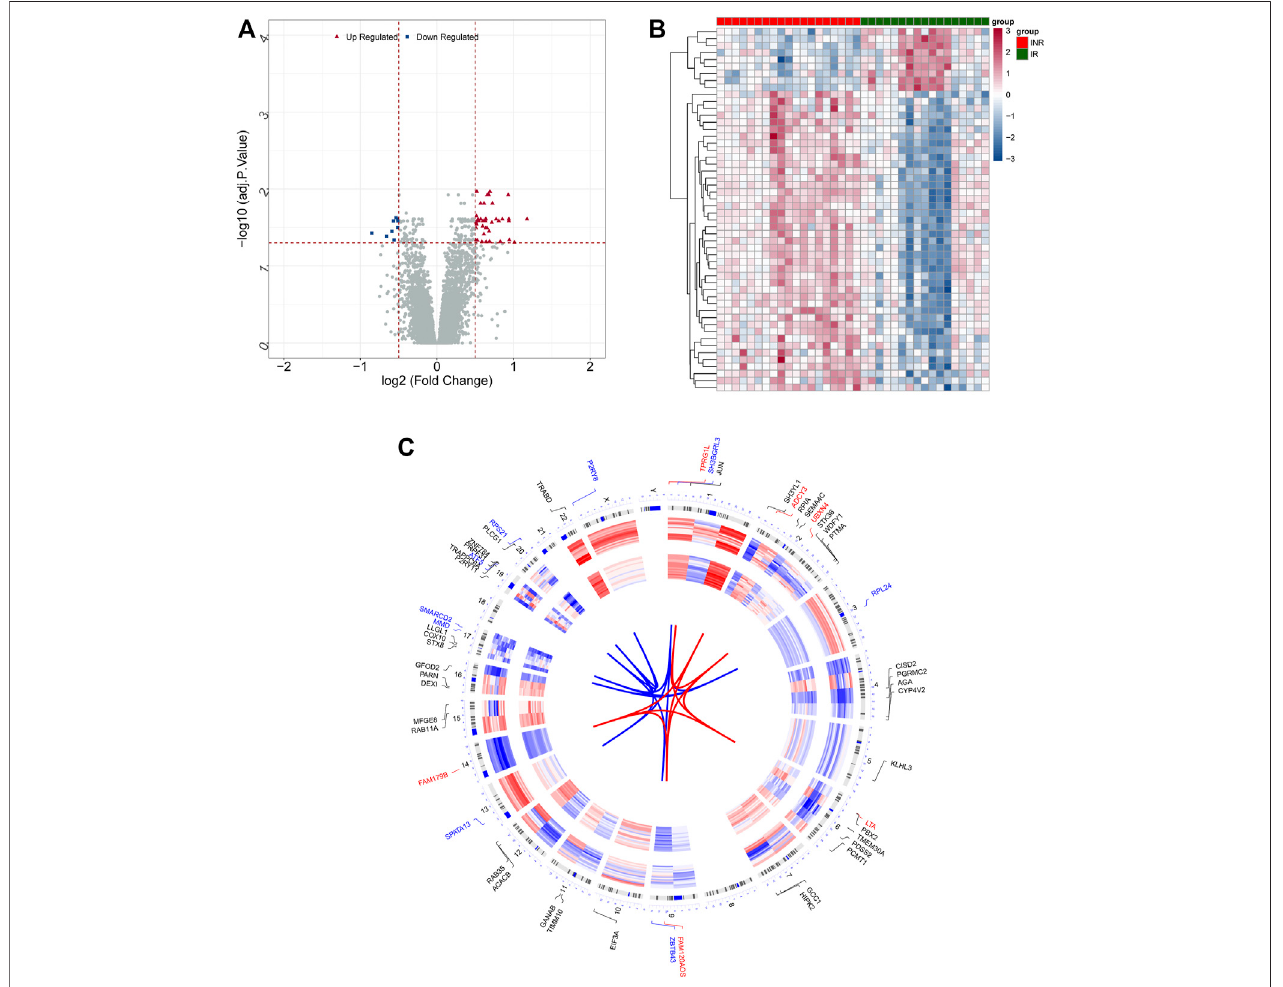
FIGURE 1 | Identi fi cation of DEGs between INRs and 17 IRs. (A,B) Volcano plot (A) and Heatmap (B) presented the expression of DEGs. (C) The chromosomal locations and expression patterns of DEGs.